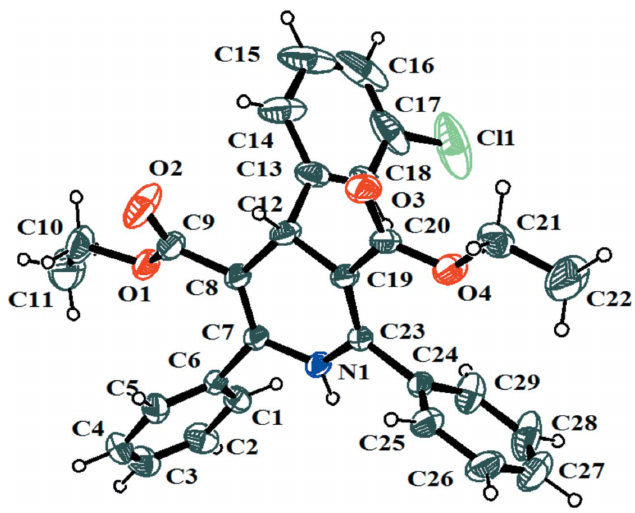
Figure 1 The molecular structure, with 30% probability displacement ellipsoids for non-H